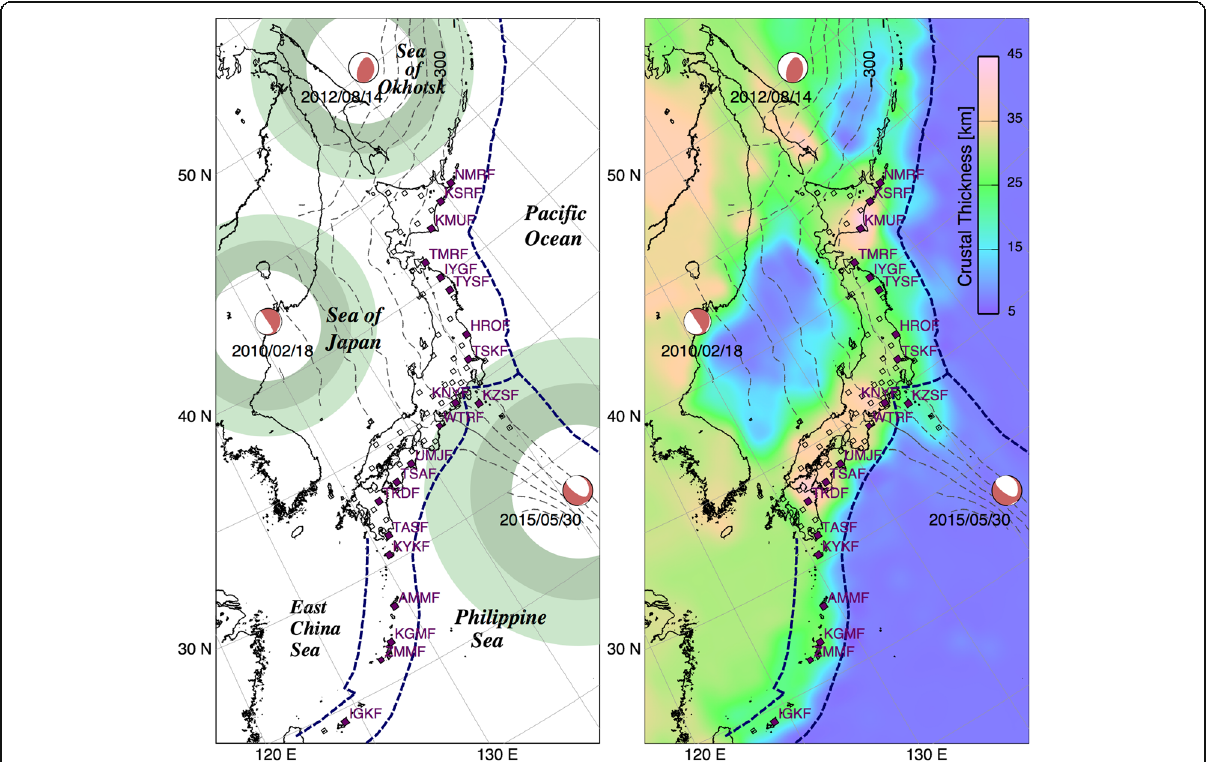
Fig. 5 Configuration of very deep earthquakes and F-net stations, superimposed on crustal thickness (from CRUST1.0 — Laske et al. 2013). The stations displayed in Figs. 6, 7 and 8 are annotated and have filled symbols. The zone of conversion from upgoing S to P is indicated for upper mantle propagation (sPn) in darker tones in the left panel and for crustally guided P (lighter tones). The size of the conversion zones increases with source